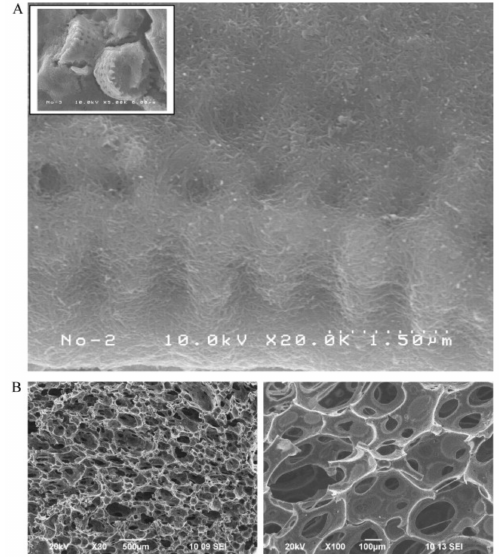
Figure 3. ( A ) Prussian blue was sealed into the cavities of the diatomite (upper, lower resolution). The diatomite surfaces were coated with highly dispersed multi-walled CNTs (upper, high resolution). The CNTs formed a continuous, interconnected network that prevented the diffusion of Prussian blue particles. ( B ) Representative SEM images of the quaternary (polyurethane polymer, CNTs, diatomite, and Prussian blue, PUP/CNT/DM/PB), spongiform, Prussian blue based adsorbent. Reproduced with permission from [57]. Copyright Elsevier,